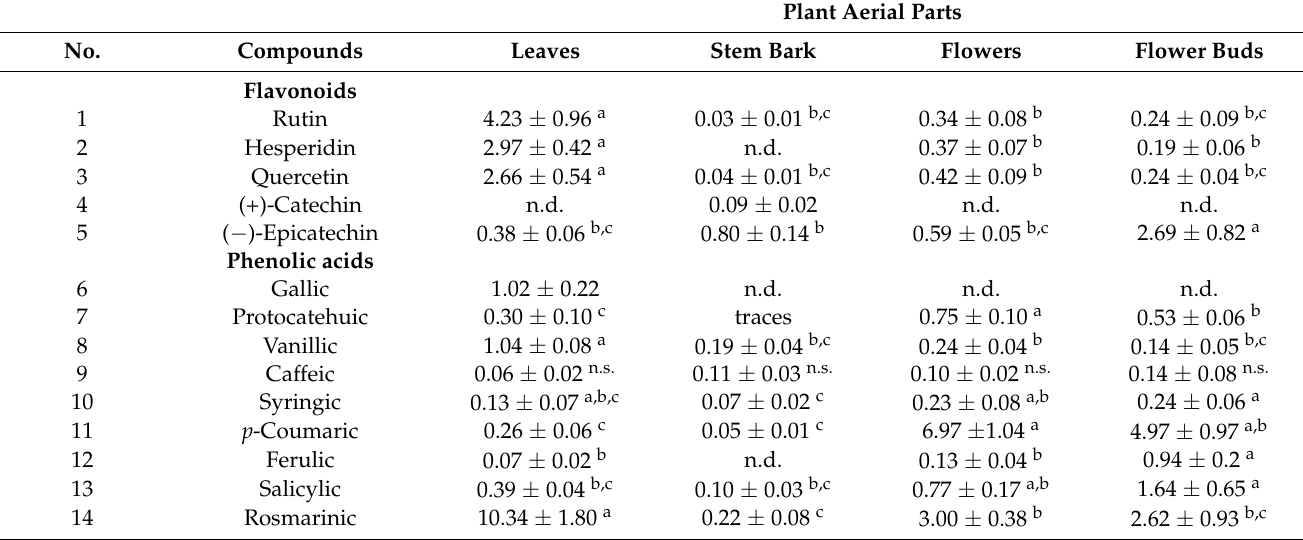
Table 1. Content of flavonoids and phenolic acids in extracts of Koelreuteria paniculata aerial parts (mg/g